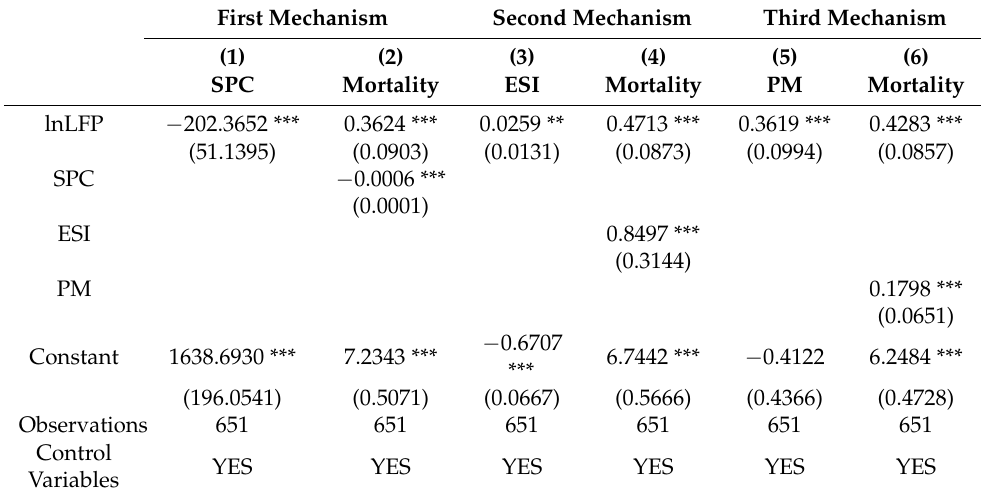
Table 4. Mechanism check